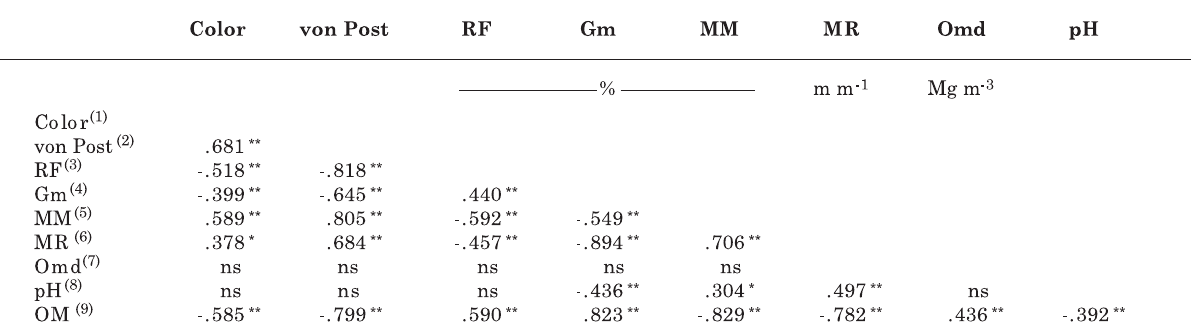
Table 2. Coefficients of simple correlation (Pearson analysis) compared to the association degree of the determined